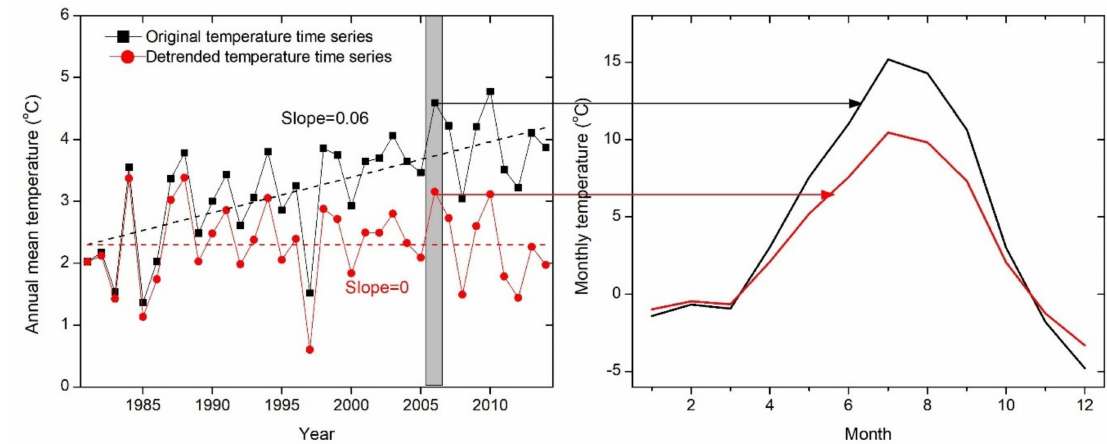
Figure 4. Schematic of the detrending method for a time series of annual average temperature. This method would eliminate the annual trend in observed climatic variables but would not impact seasonal variations in climatic